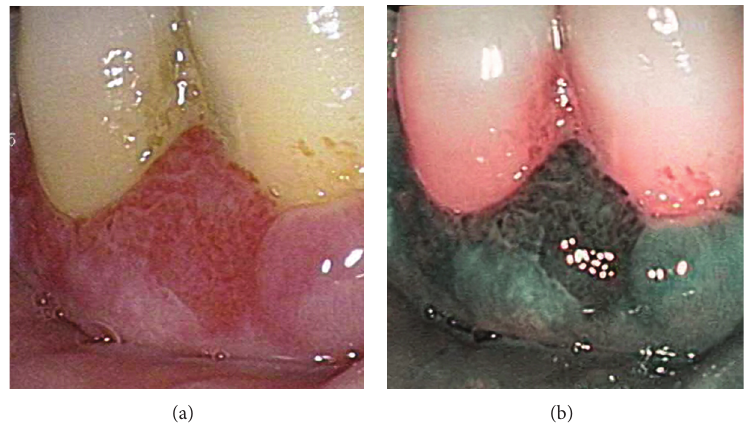
Figure 3: SCC of the gingiva viewed with endoscopic white light (a). Same lesion viewed in NBI mode demonstrating Type IV IPCL pattern